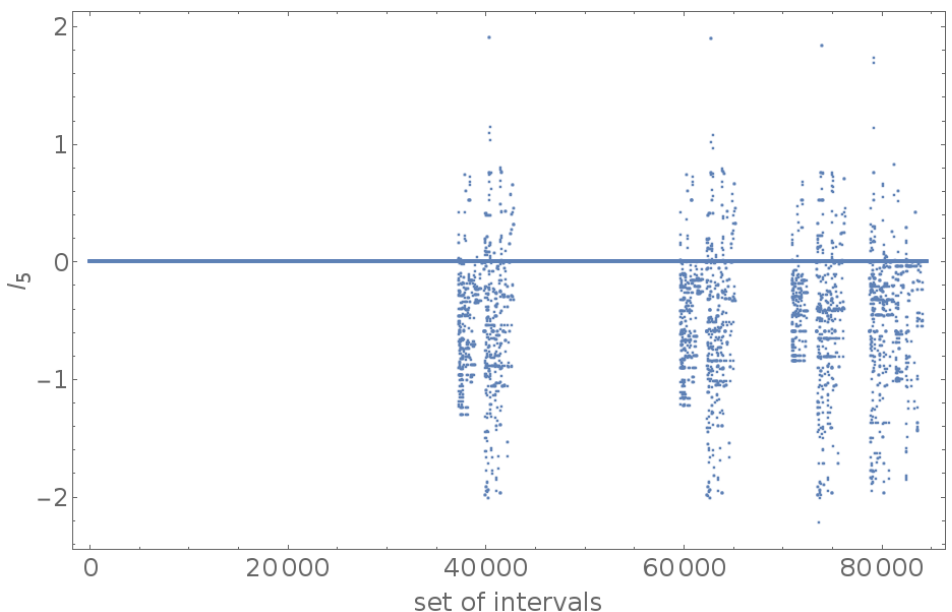
Figure 21 . Five-partite information for the 84579 sets of (cid:12)ve intervals (out of initially 184756) for which the total entanglement entropy is not in the totally disconnected phase. Clearly there are multiple violations of the proposed inequality (6.20). As in (cid:12)gure 20, we are here displaying results for the example where T L = 9, T R = 1 and the boundary time t = 1.